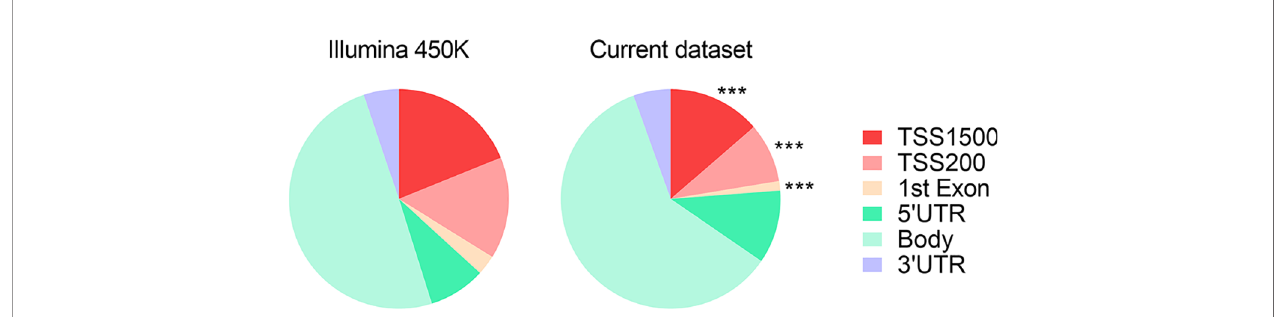
FIGURE 2 | Pie chart representing the proportions of genomic features with associated DMRs between subjects with MUHO and respective controls with MHO. *** indicates P < 0.0001 by c 2 tests with Yates ’ correction. Data derived from refs (63,